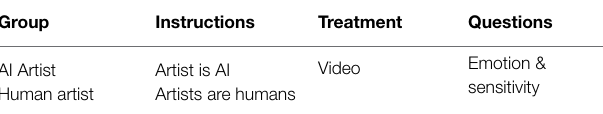
TABLE 1 | Design summary of experiment